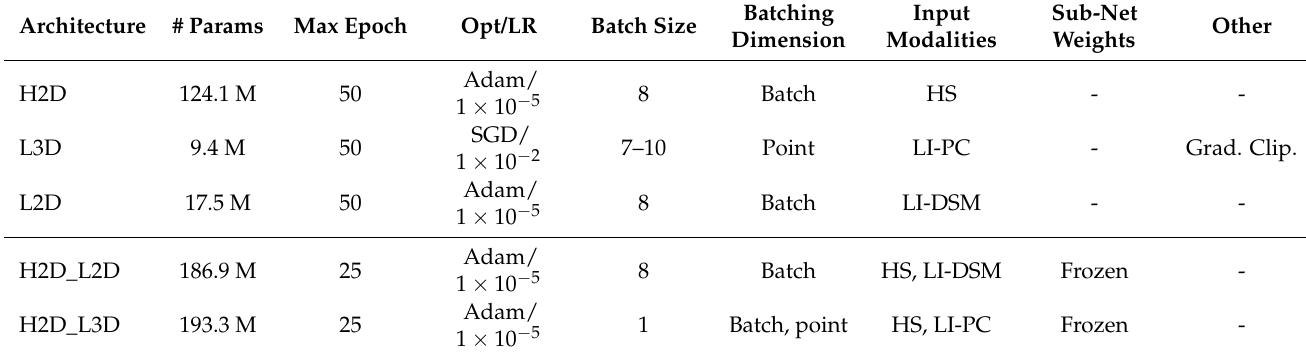
Table 2. Distinctive model training hyperparameters and characteristics. Batching dimension “batch” refers to a new batch dimension along which input samples are stacked, “point” refers to the stacking samples in the same point dimension and utilizing pre-computed neighbor indices to discriminate samples. Sub-net weights refer to H2D and L2D within H2D_L2D along with H2D and L3D within